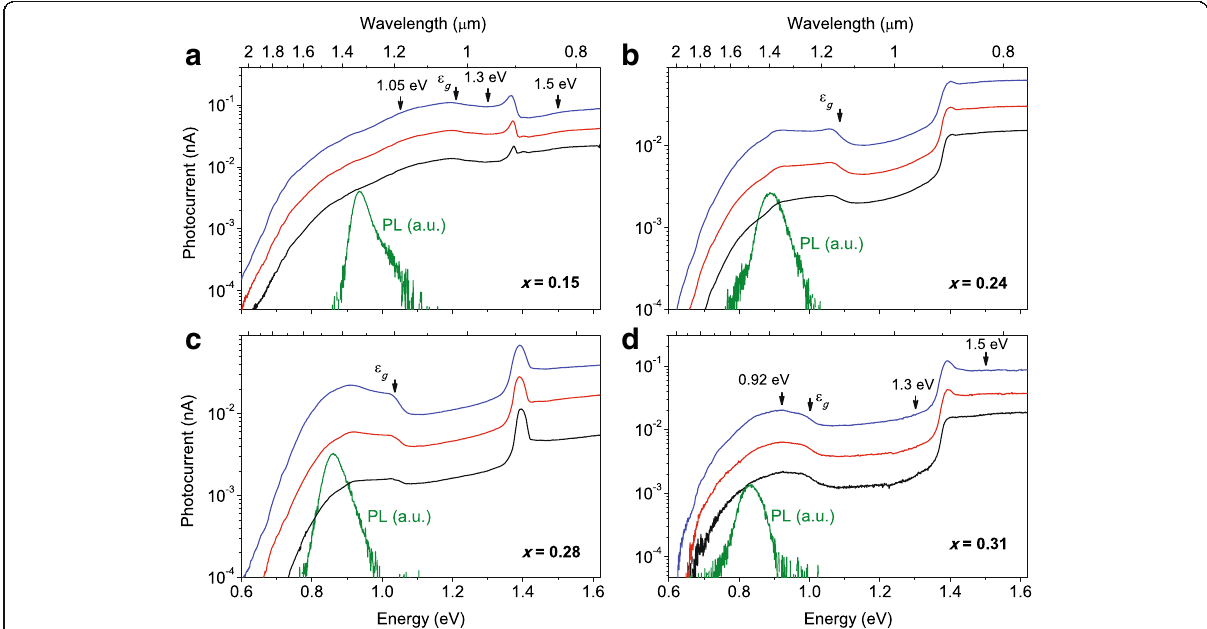
Fig. 3 Color online. PC spectra of the metamorphic InAs/In x Ga 1 − x As structures at room temperature and a bias of 11 V for x = 0.15 ( a ), 0.24 ( b ), 0.28 ( c ), and 0.31 ( d ). The excitation intensities for the black, red, and blue curves at 1.3 eV correspond to 88, 350, and 1400 μ W/cm 2 , respectively. PL spectra in arbitrary units are given for the energy positioning of QD ground state transitions. The vertical arrows mark the InGaAs bandgaps ( ε g ) calculated following Paul et al. [48] and spectral positons, where the PC dependencies on excitation intensity were measured (given in Fig.